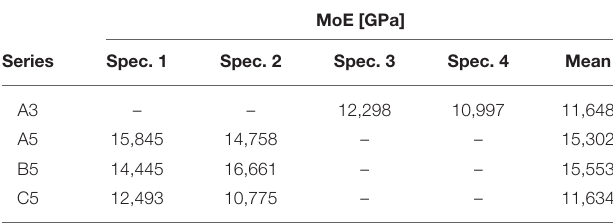
TABLE 2 | Modulus of Elasticity values [GPa]. TABLE 3 | Values of applied force and relative shear and bending moment at